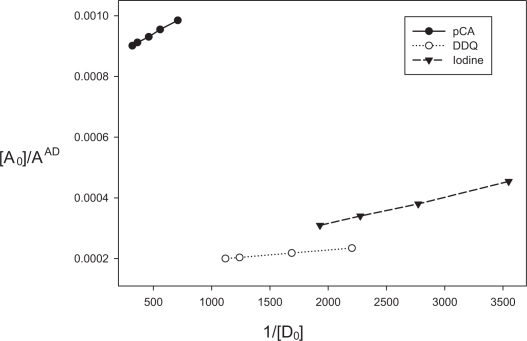
Plot of 1/[D0] vs [A0]/AAD for Methods B, C and D.